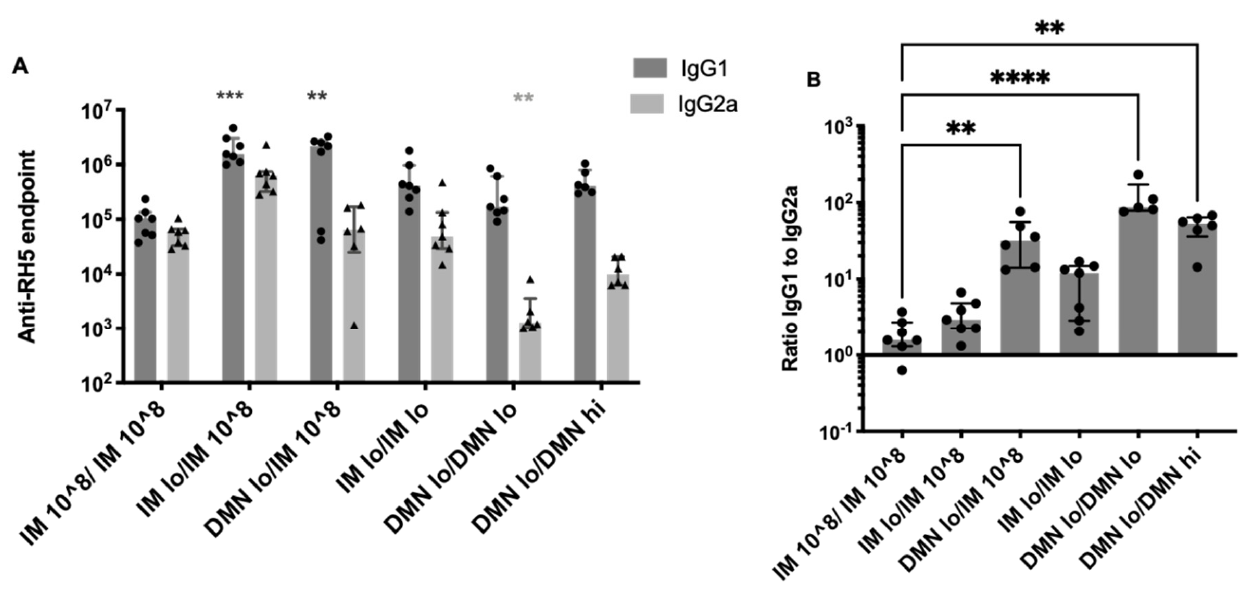
Figure 5. IgG subtypes induced by repeated immunization with low or high dose of vaccine by IM or skin route. Female Balb/c mice ( n = 7 per group) were immunized on day 0 with AdHu5–PfRH5 by the IM route or using DMN patches. Mice were administered the standard 1 × 10 8 ifu by IM injection twice (“IM 10ˆ8/IM 10ˆ8”). Alternatively, mice were administered a low dose of 5 × 10 4 ifu by IM injection or DMN patch (“IM lo” or “DMN lo”) or a high dose of 5 × 10 7 ifu by DMN patch (“DMN hi”). All mice were boosted on day 54 with a low or high dose or 1 × 10 8 ifu of vaccine by the indicated route. ( A ) The endpoint titre of RH5-specific IgG1 (dark grey bars) and IgG2a (light grey bars) in serum taken at day 84 (4 weeks post-boost). ( B ) The ratio of IgG1 to IgG2a in each animal. Bars represent median, lines represent interquartile range, triangles and circles represent individual samples. ** p < 0.01; *** p < 0.0005, **** p < 0.0001 by Kruskal–Wallis one-way ANOVA comparing all groups to IM 10^8/IM 10^8.